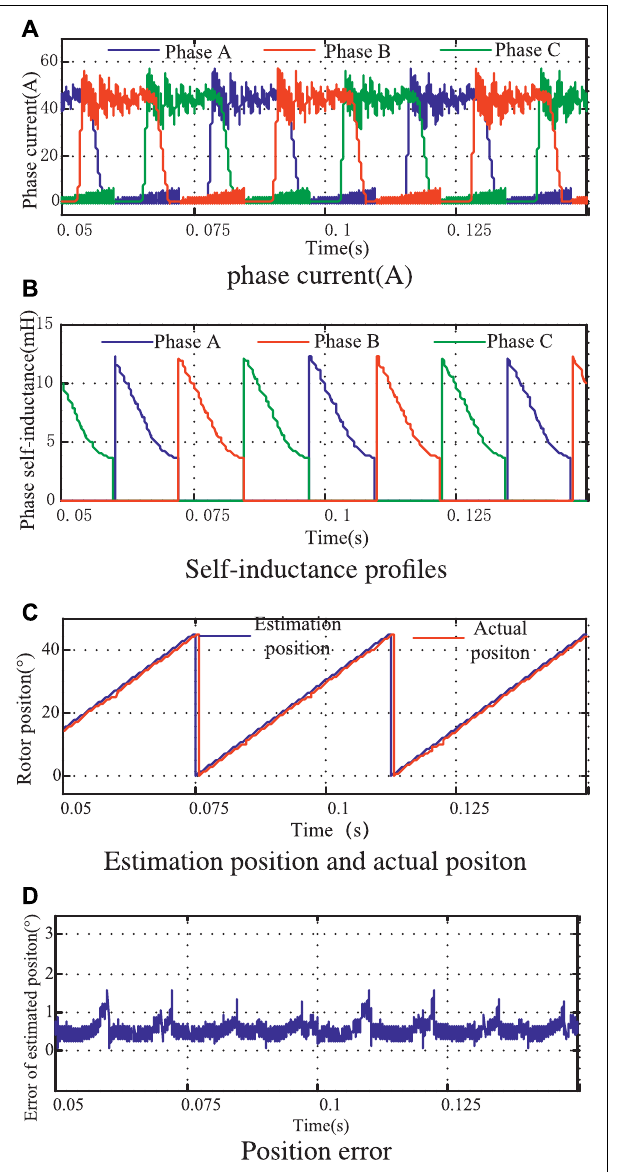
FIGURE 10 | Simulation results without proposed estimation under heavy load. (A) Profiles of phase current. (B) Phase inductance profile. (C) Estimation position and actual position. (D) Estimated